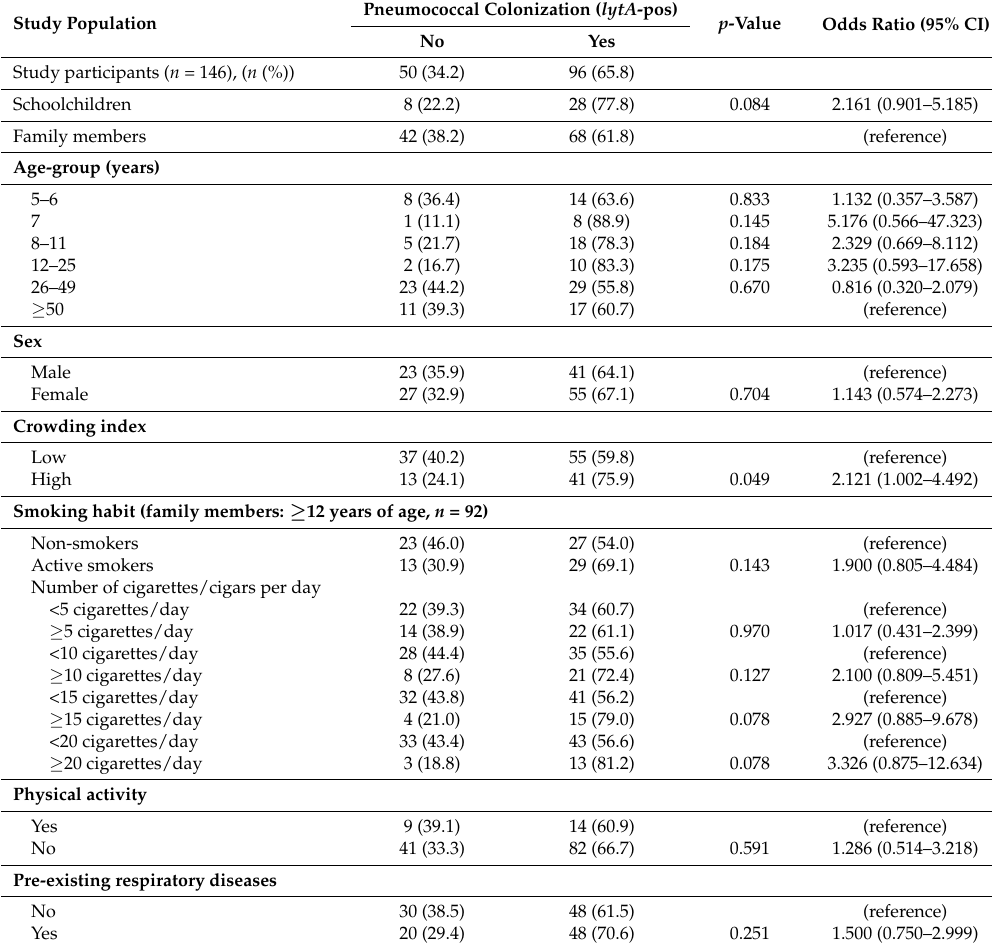
Table 2. Main socio-demographic characteristics and vaccination status of the study population, according to pneumococcal colonization ( lytA -pos vs. lytA